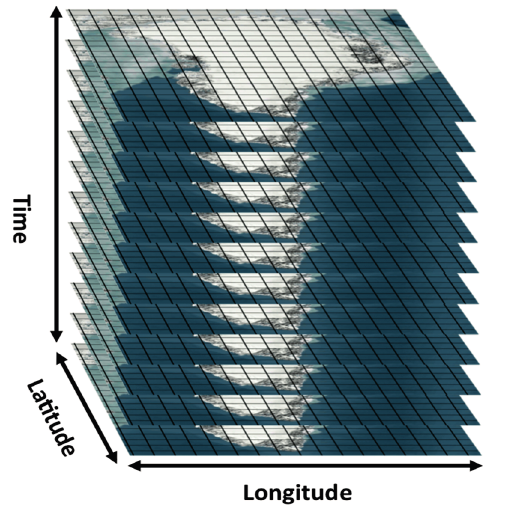
Figure 1. Stacked grids of imagery that form the basis of the three-dimensional Data Rods database structure. Within the database, pixels are stored in temporal order ( vertically ) at each grid cell rather than spatially ( horizontal ). A vertical column of pixels at a single grid cell makes up one data